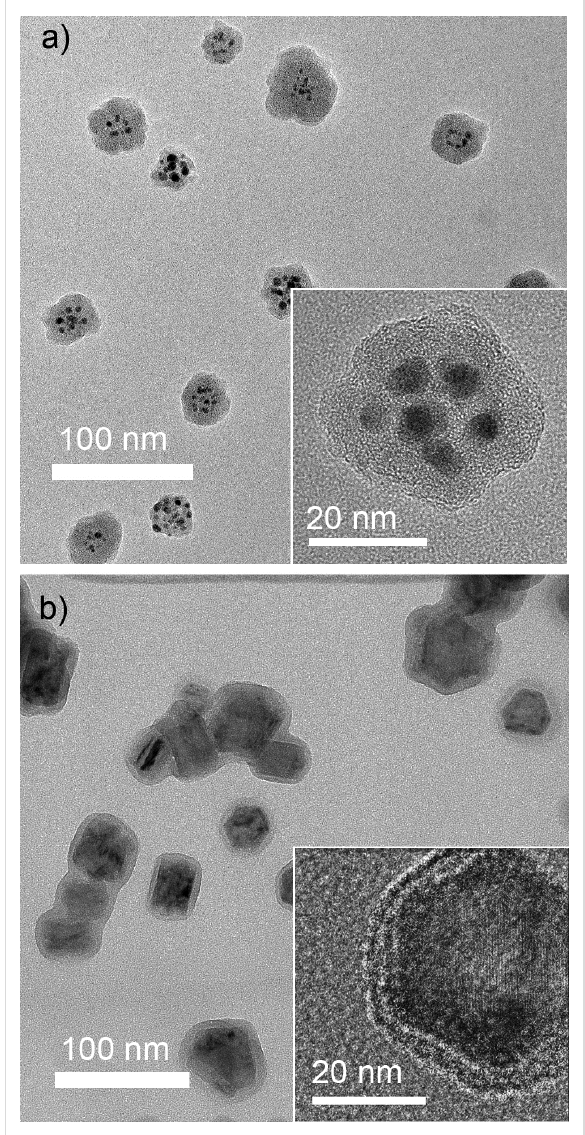
Figure 13: TEM images of core@shell NPs: a) Ag@HMDSO NPs pre- pared in configuration of Figure 12a (total pressure 190 Pa, discharge power 50 W, HMDSO flow 0.45 sccm, Ar flow 105 sccm); b) Ti@C/H NPs prepared in configuration of Figure 12b (Ar pressure/flow in the GAS is 40 Pa/4.0 sccm, DC 0.4 A, total pressure in the auxiliary plasma zone is 1 Pa (0.65 Pa of Ar and 0.35 Pa of C 6 H 14 ), RF power is 10